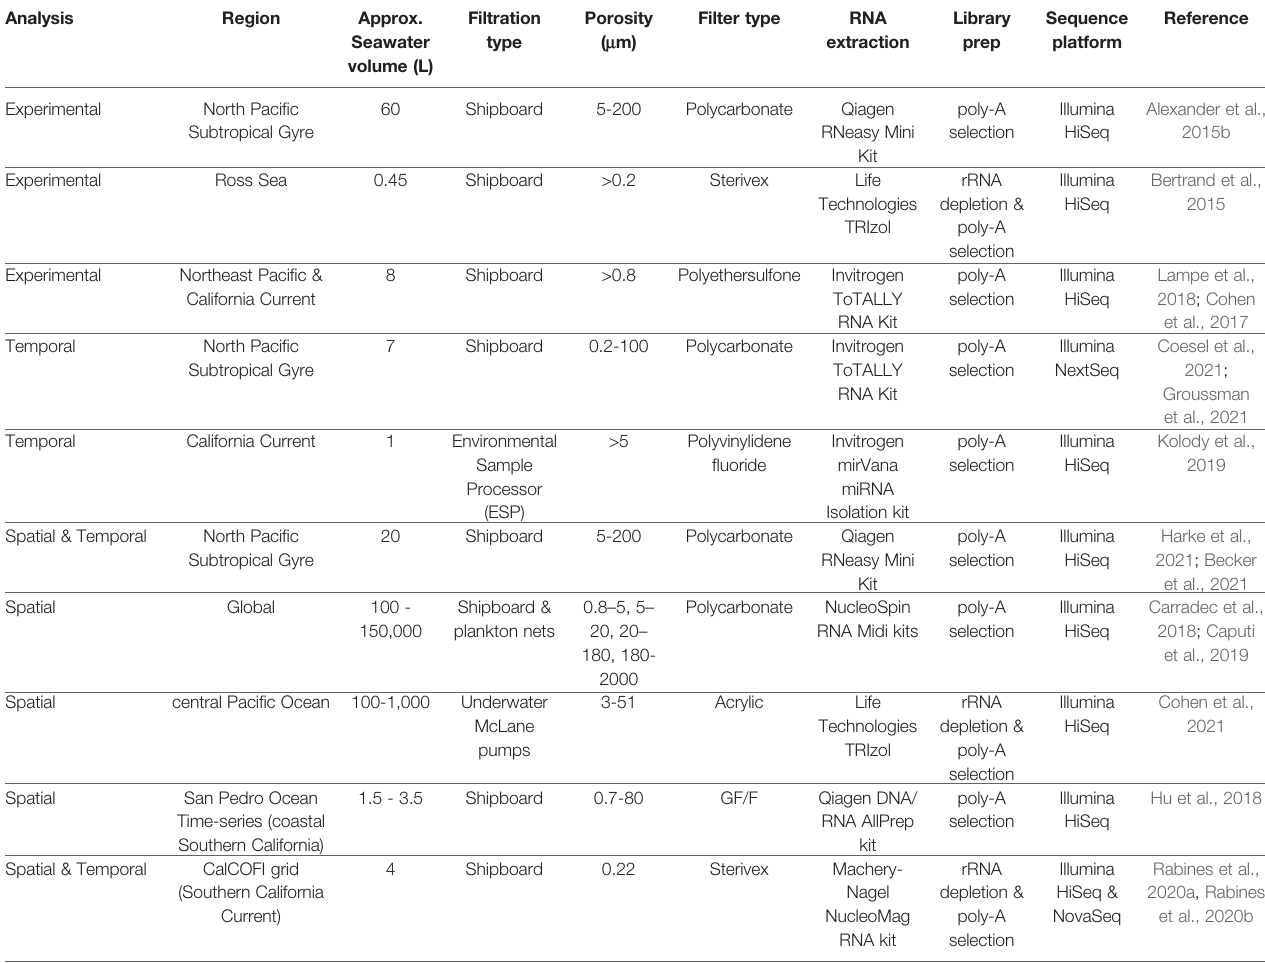
TABLE 1 | Field processing procedures in recent marine microeukaryote metatranscriptomic